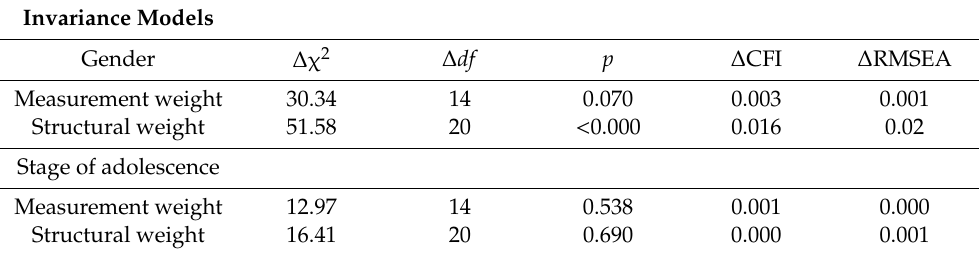
Table 2. Results of the invariance analysis by gender and stage of adolescence (early vs.